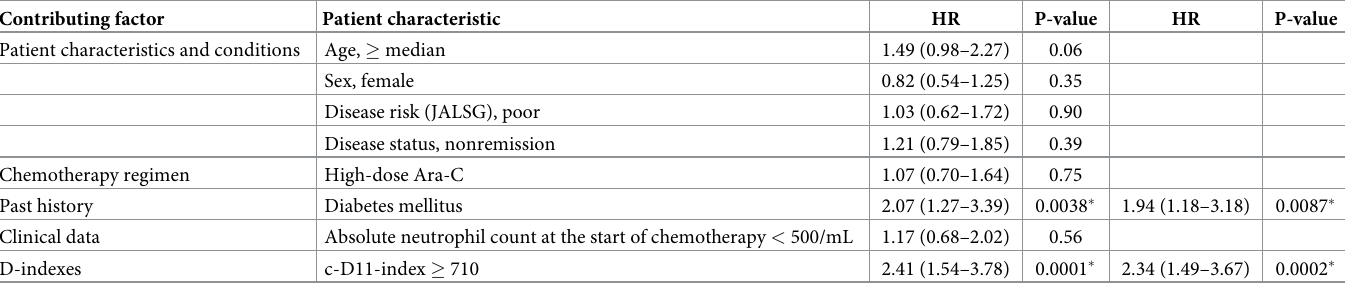
Table 2. Risk factors for the onset of febrile